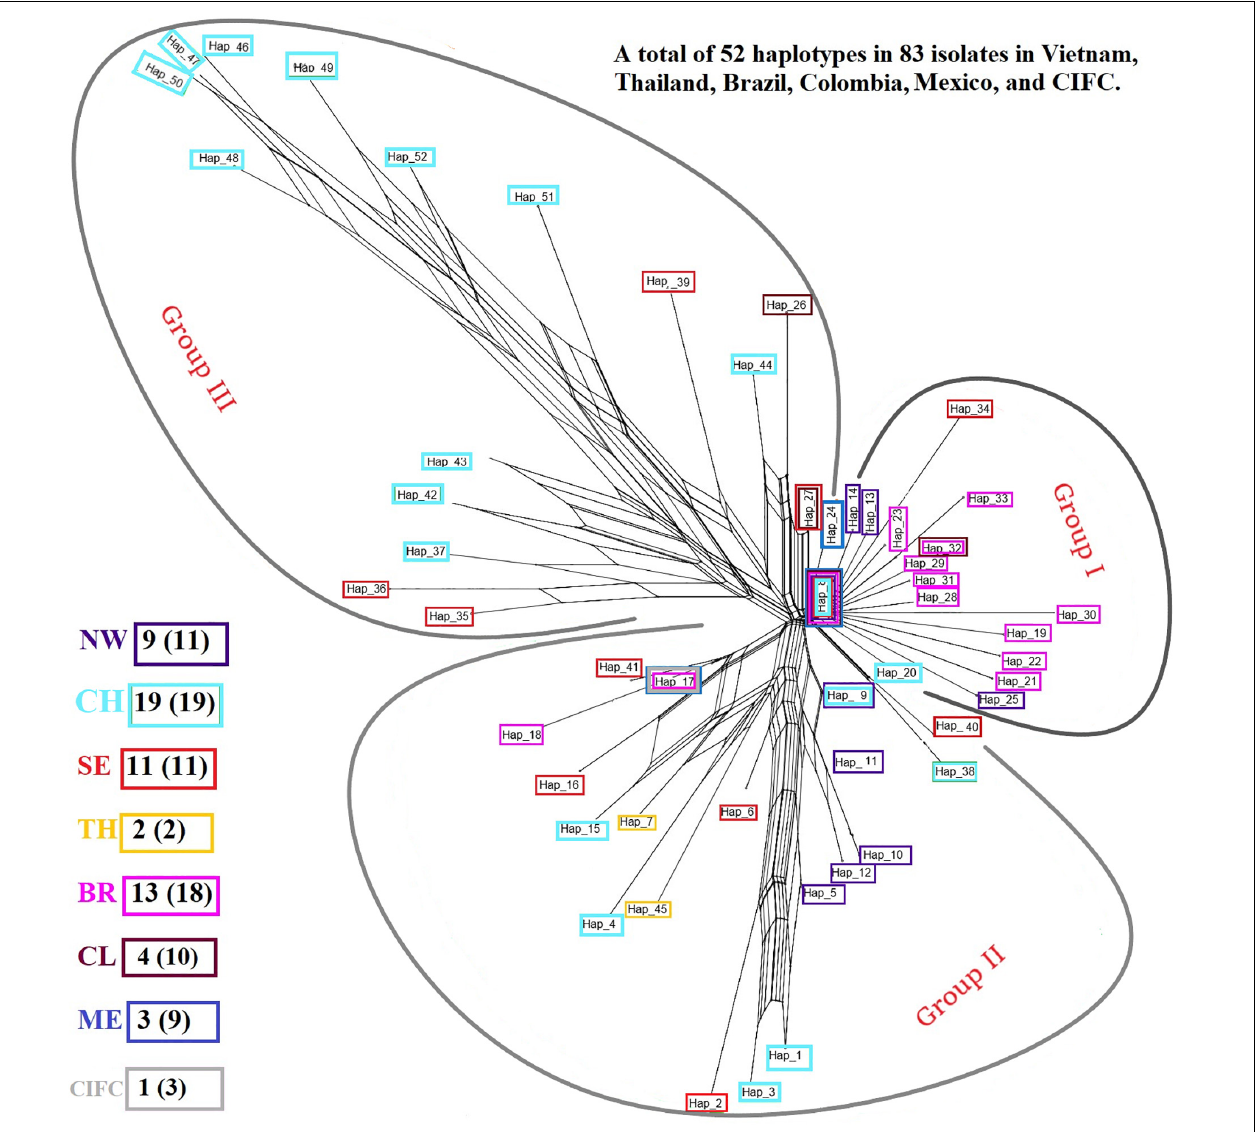
FIGURE 4 | NeighborNet graph constructed from the pairwise FST values of Hemileia vastatrix samples from Vietnam, Thailand, Portugal, and other American countries (Brazil, Colombia, Mexico) based on their ITS regions. The haplotypes detected in seven areas are framed in boxes with different colors: purple indicates the Northwest (NW) of Vietnam, light turquoise the Central Highlands (CH) of Vietnam, bright red the Southeast (SE) of Vietnam, while yellow indicates Thailand (TH), pink Brazil (BR), brick red Colombia (CL), blue Mexico (ME), and grey the Centro de Investigação de Ferrugens do Cafeeiro (CIFC)-Portugal. After the abbreviation of each region the number of haplotypes detected in each area is stated, and the number in the parentheses indicates the number of sequences obtained from the